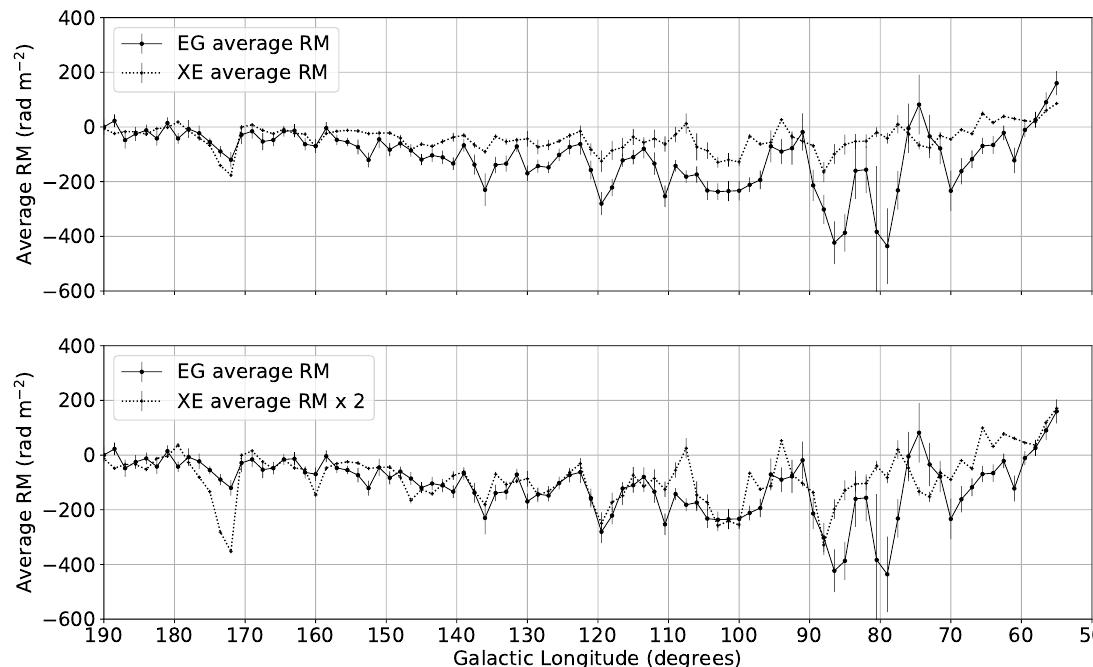
Figure 4. Top: The average EG RMs (solid line) and the average XE RMs (dotted line) within independent bins each spanning 1.5 degrees of longitude and covering the CGPS latitudes, b = − 3 ◦ to + 5 ◦ . Bottom: The average EG RMs (solid line) and the average XE RMs multiplied by two (dotted line).